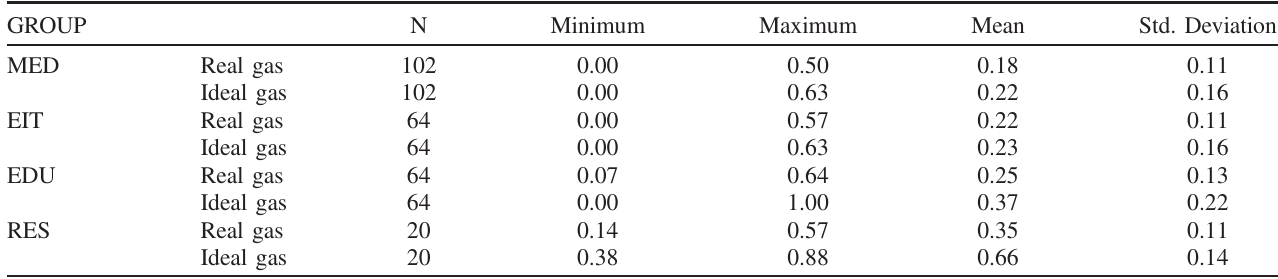
TABLE VI. An analysis of between-group differences on the two (ideal gas vs real gas) subgroups of items — minimum, maximum, mean, and standard deviation of the proportion of correct answers are shown.